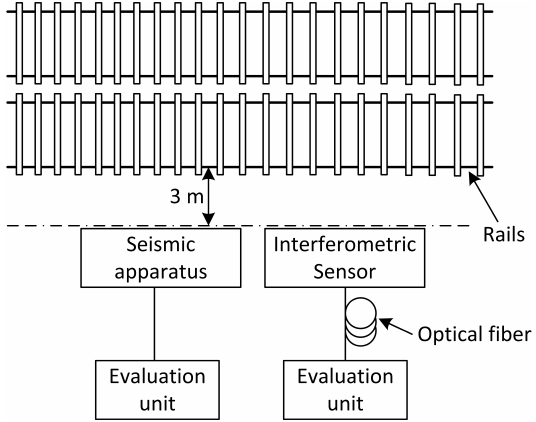
Figure 9. Methodology of tram detection measurements.